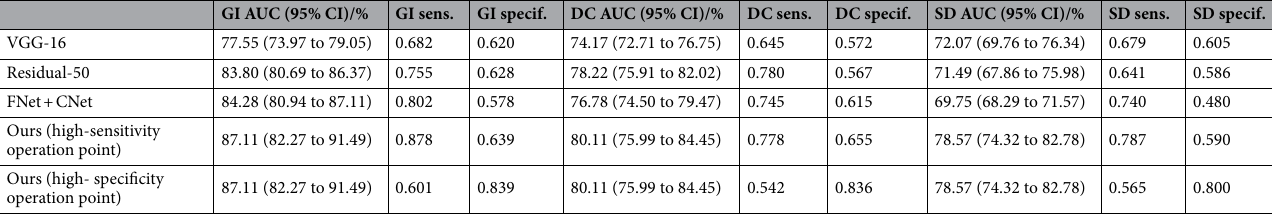
Table 3. Summary of classification performance of different models. classification AUC (in percentage), sensitivity (Sens.), specificity (Specif.) are measured for gingivitis (GI), dental calculus (DC), and soft deposits (SD).